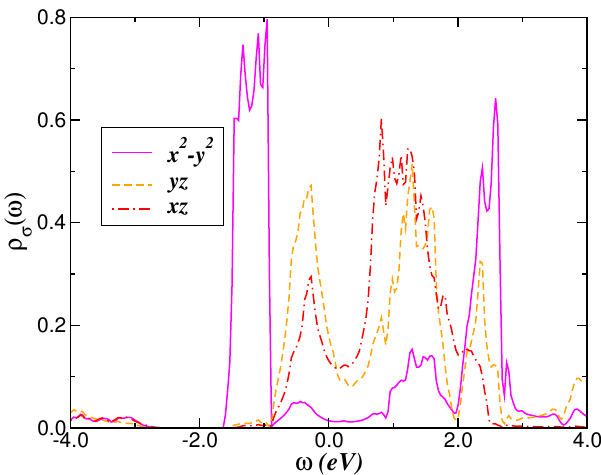
Figure 1. Partial LDA densities-of-states (DOS) of MoO 2 within the monoclinic symmetry. Notice the splitting of LDA the bands into bonding and antibonding branches in the projected d x 2 − y 2 DOS, a characteristic property of monoclinic materials.